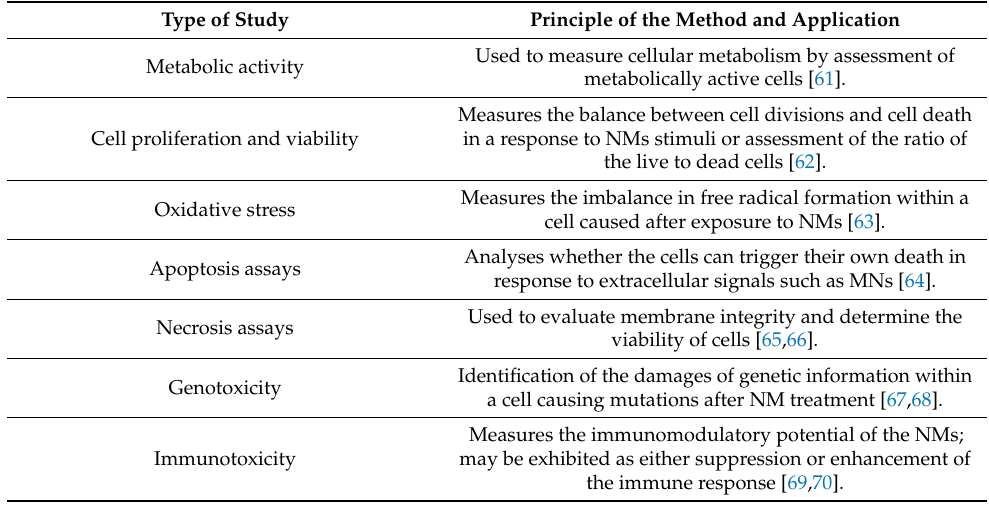
the immune response